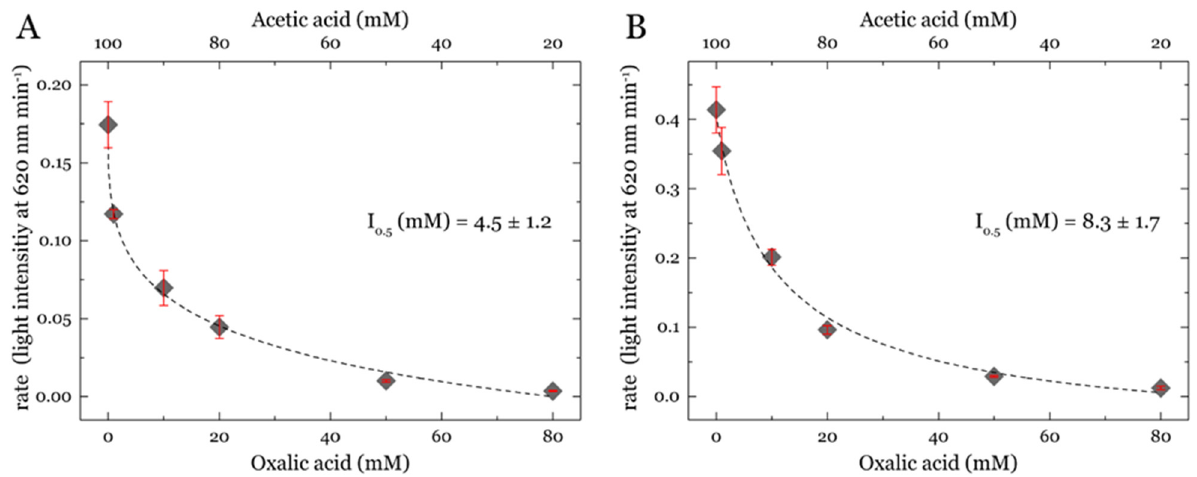
Figure 3. IC 50 plots showing inhibition of the peroxygenase reaction rate for Nc LPMO9C with increasing oxalic acid and decreasing acetic acid concentration. LPMO peroxygenase activity was tested on PASC using a turbidity assay. Reaction was started with H 2 O 2 and rates were obtained from light-intensity decrease at 620 nm. Assay contained 0.5 µ M ( A ) or 1.0 µ M ( B ) Nc LPMO9C, 0.8 mg mL − 1 PASC, 1 mM ascorbic acid and 100 µ M H 2 O 2 , respectively. H 2 O 2 was added after 30